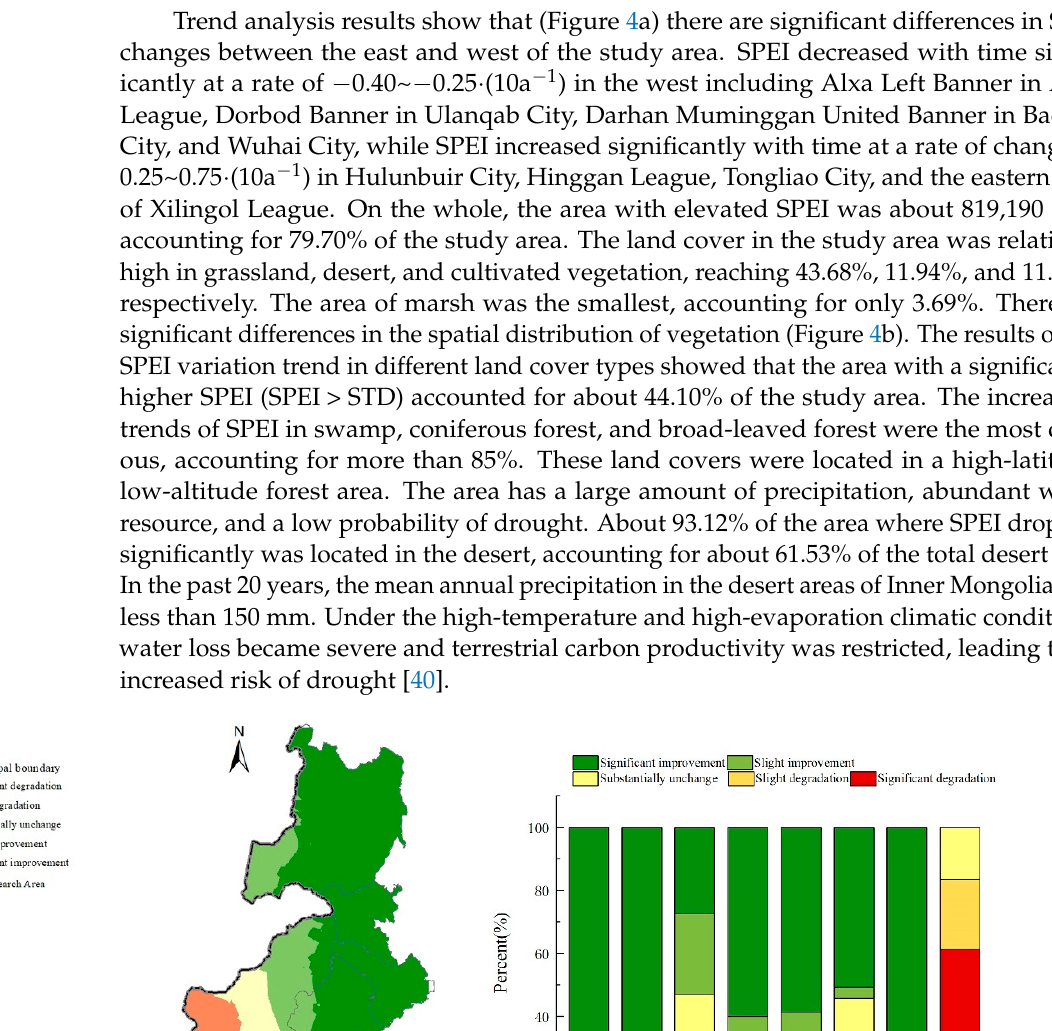
Table 4. q statistics and ecological